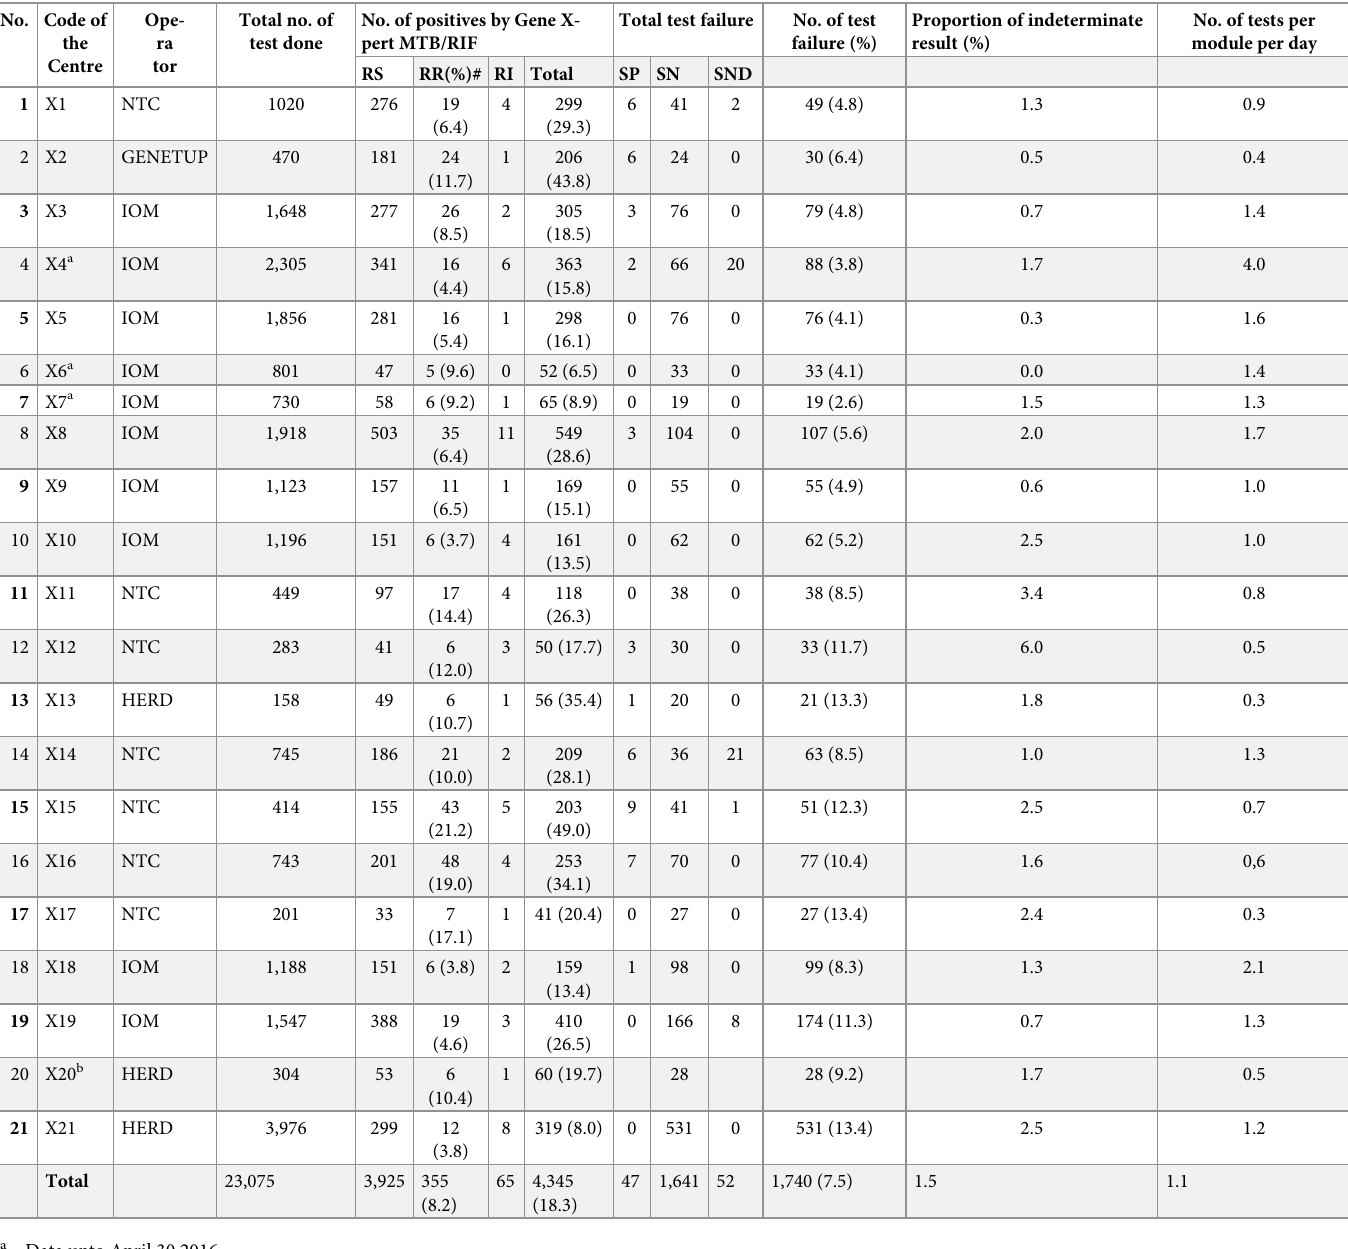
Table 1. Annual performance scores of Gene X-pert MTB/RIF centres in Nepal, 2015–2016. No. Code of